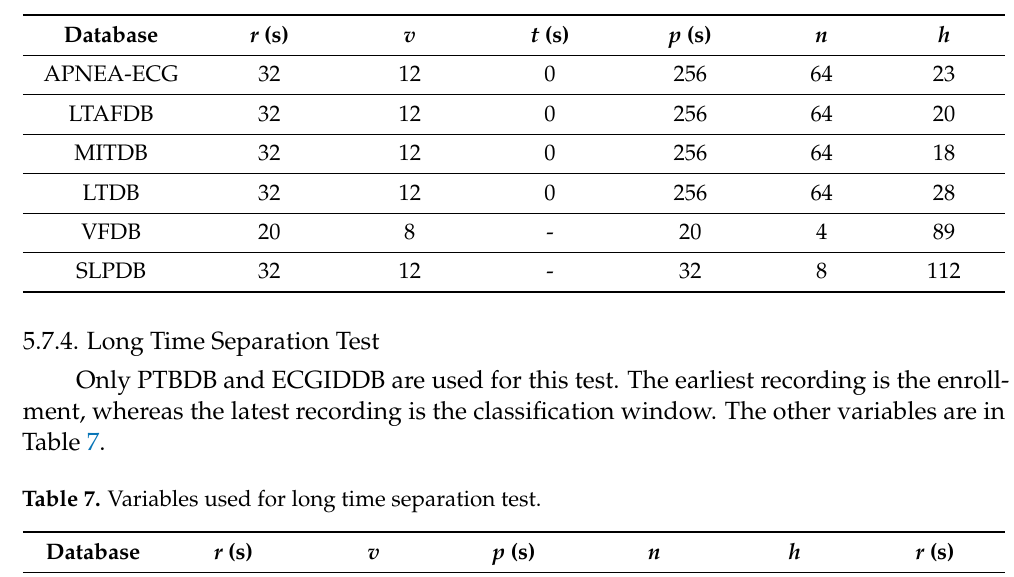
Table 6. Variables used for short time separation test.